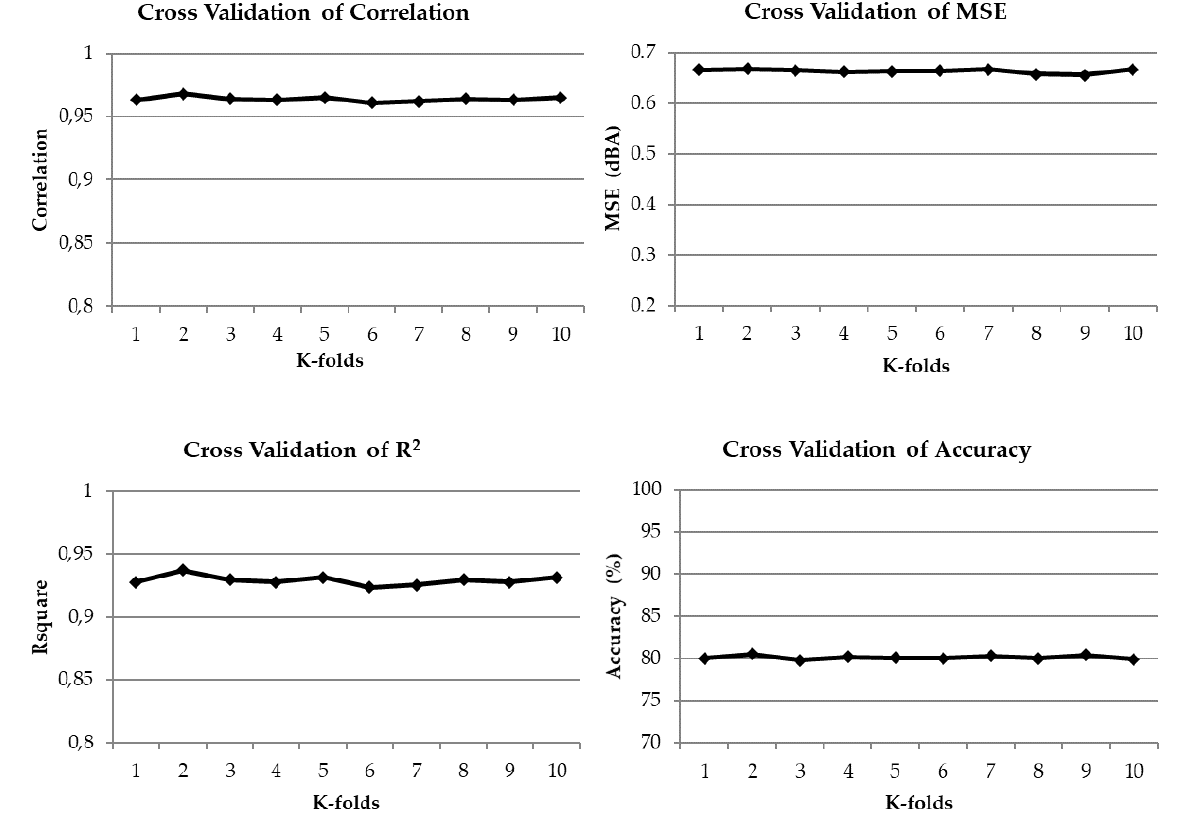
Figure 6. A ten-fold cross validation for r, R 2 , MSE and accuracy for the generalized linear model (GLM).